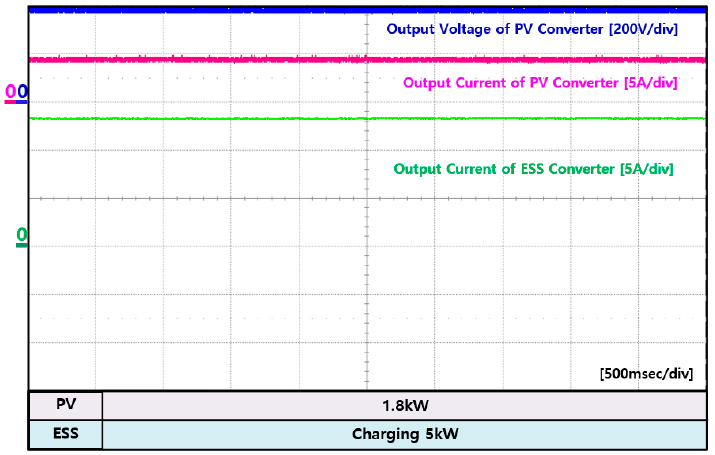
Figure 16. Experiment waveforms of DC load and multi-level inverter in mode 2.